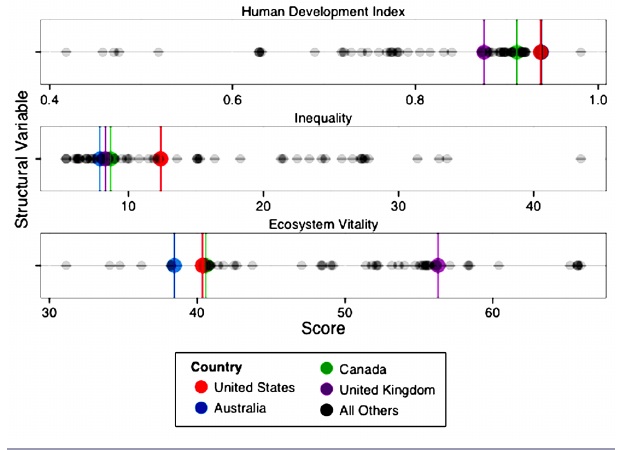
Fig. 1 . Structural variables: national indices of development, inequality, and ecosystem vitality across 45 countries. Distribution of scores on three national-level indices for the 45 countries in the sample. The four top-responding countries are shown in color, and the remaining 42 countries are in grey. The indices are each multidimensional, and dervied from the following sources. Human Development Index (HDI) is compiled by United Nations Development Programme (UNDP), Inequality is the penalty to HDI calculated as part of the Inequality-Adjusted Human Development Index (also compiled by UNDP), and Ecosystem Vitality is part of the Environmental Performance Index complied by Yale University and Columbia University. Although the four top-responding countries respresent the bulk of the responses, they only represent a small portion of the range of national-level conditions represented in the